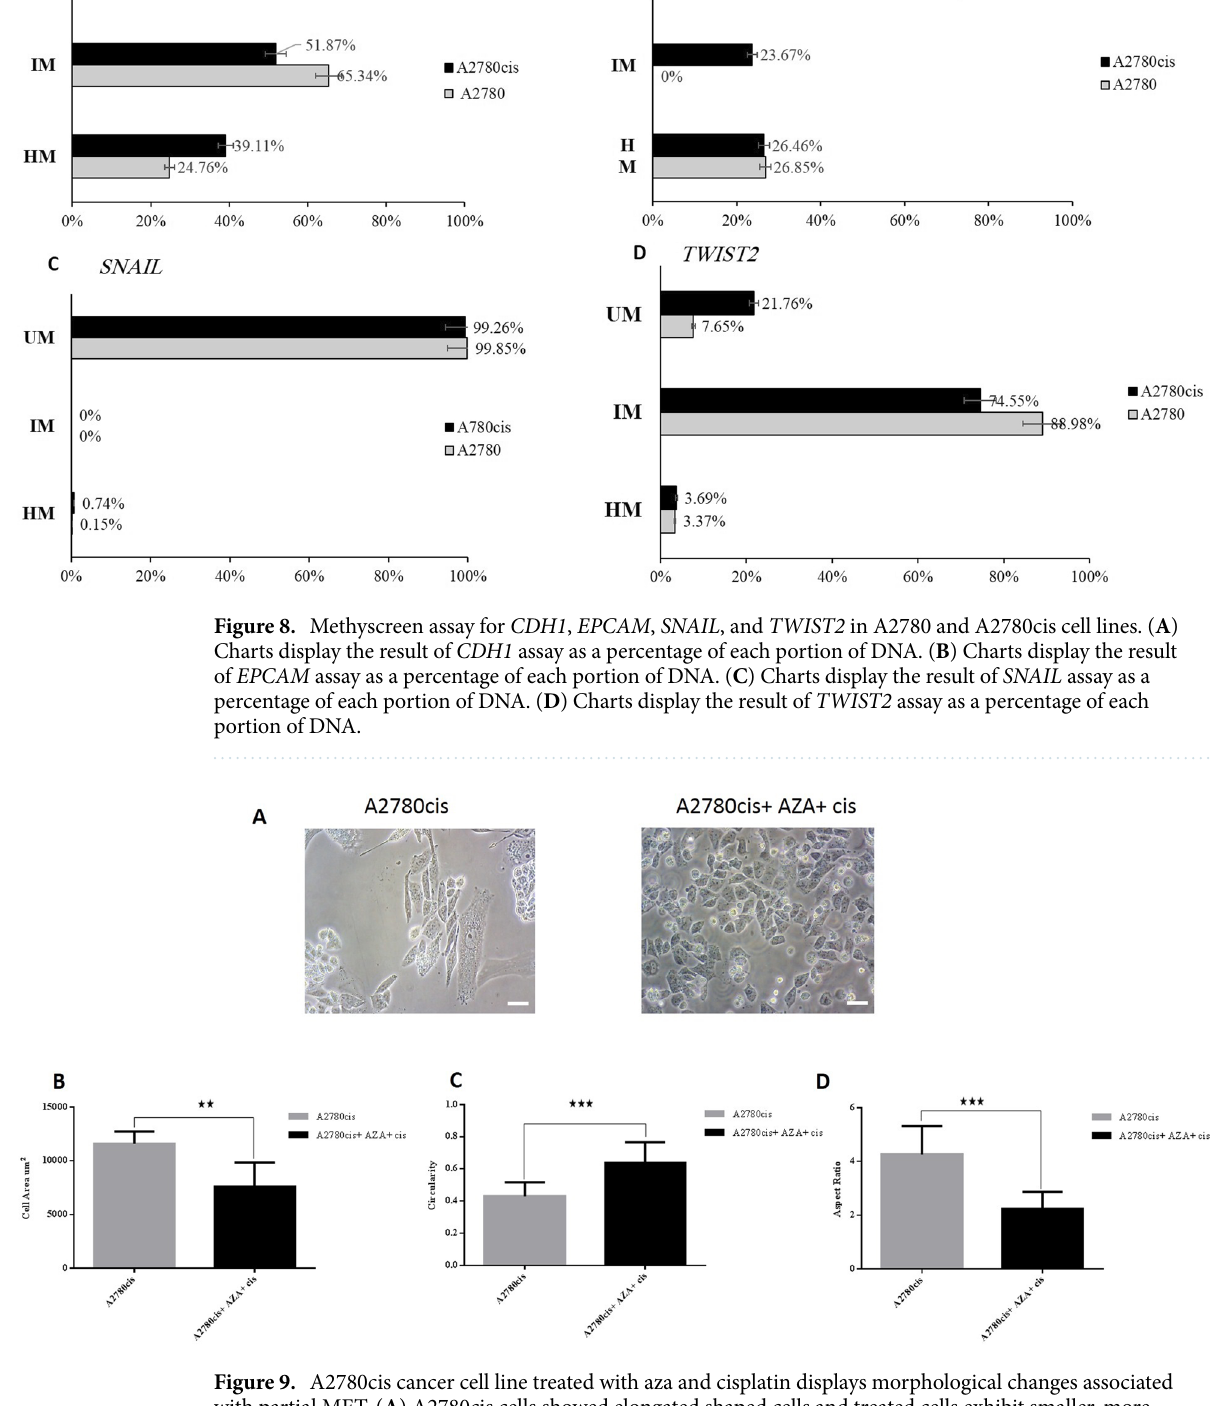
Figure 9. A2780cis cancer cell line treated with aza and cisplatin displays morphological changes associated with partial MET. ( A ) A2780cis cells showed elongated shaped cells and treated cells exhibit smaller, more circular shaped cells. Scale bar = 200 µm. ( B ) The mean cell area of A2780cis and A2780cis treated cells shows that treatment cause a reduction in cell size. ( C ) Cell circularity confirms that A2780cis treated cells have a higher (mean) circularity value compared to A2780cis. ( D ) Treatment of A2780cis with aza and cisplatin reduces the aspect ratio to